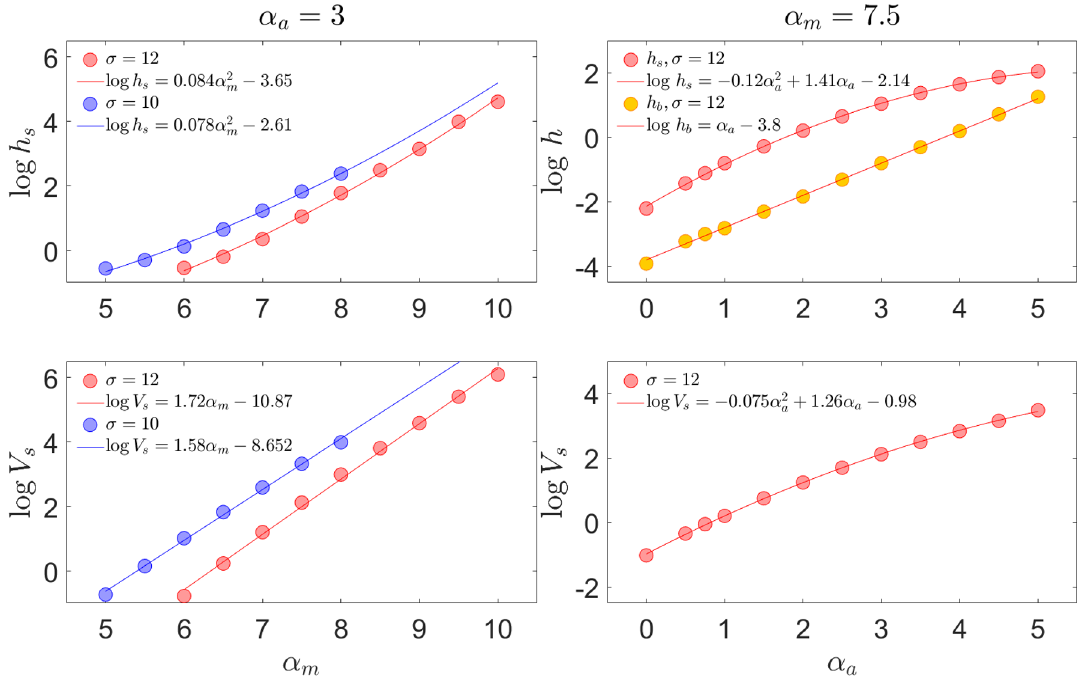
Figure 11 . The height and volume of the persistent peak as functions of α m (left column) and α a (right column). Note that the fit of log h is in very good agreement with the analytic formula (B.14) b in appendix B. The details of the various fits are shown in tables 11–13 of appendix